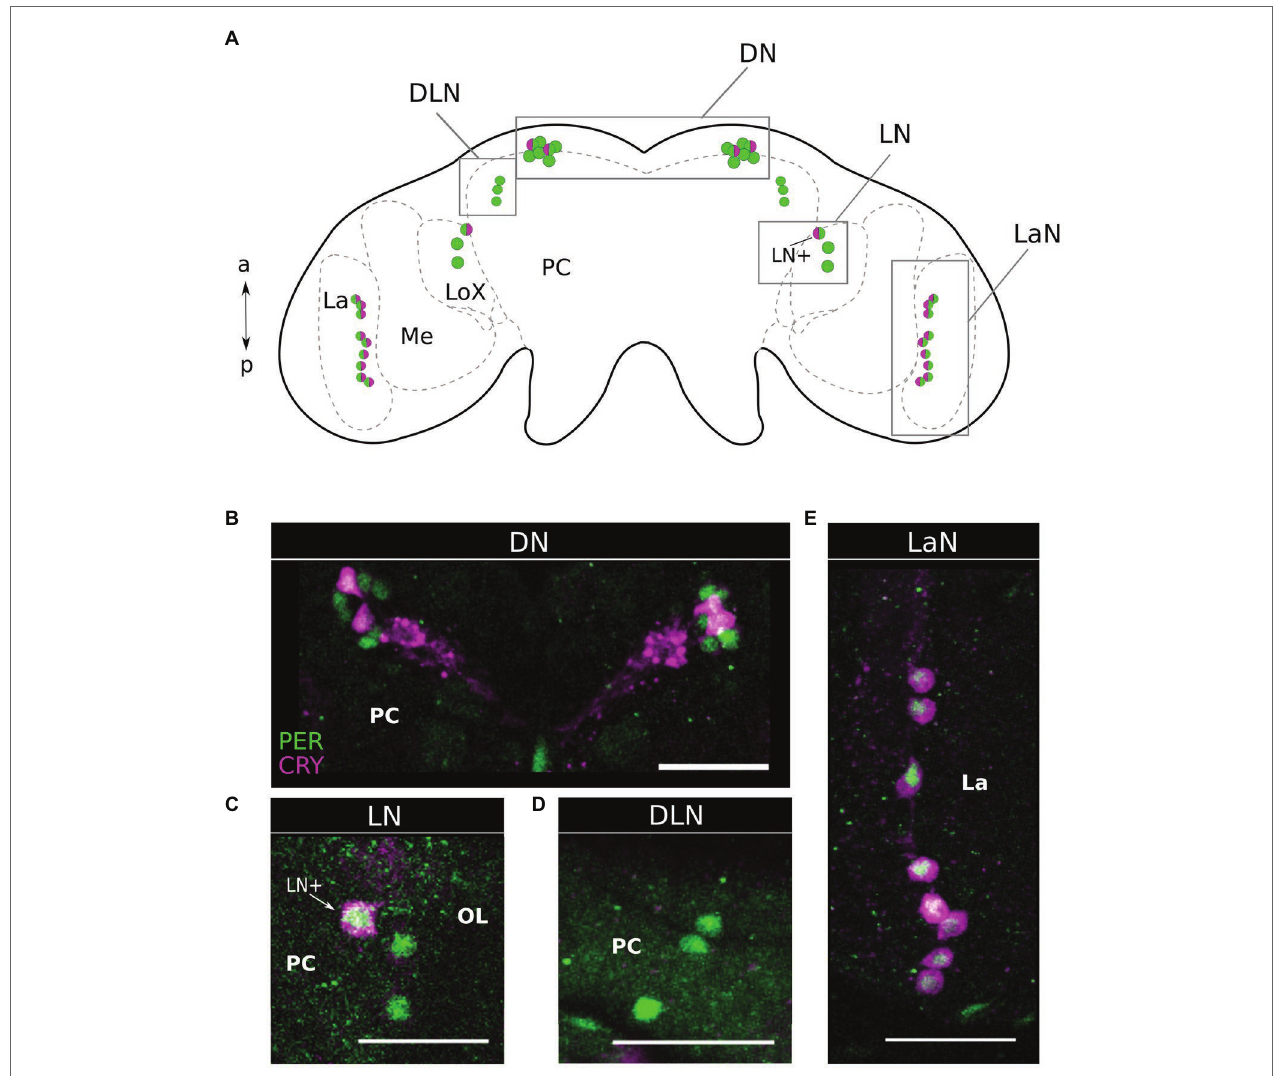
FIGURE 3 | Period and Cryptochrome are expressed in four clusters of neurons. (A) Scheme of the aphid brain with the neurons of interest. The PER expressing neuron is in green while the CRY expressing neurons are in magenta. LA, Lamina; ME, Medulla; LoX, Lobula complex; and PC, Protocerebrum. (B–E) via co-immunohistochemistry using anti-PER and anti-CRY1, we show that these clock proteins are expressed in four clusters of neurons. (D) The DLN is the only cluster of PER positive cells, in which no CRY signal is detectable. Dorsal Neurons (DN), Dorso Lateral Neurons (DLN), Lateral Neurons (LN), Lamina Neurons (LaN). OL, Optic lobe; PC, Protocerebrum; and La, Lamina. Scale bar: 30 μ